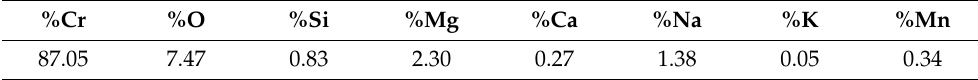
Table 4. SEM analyses of chromium rich particle marked Spectrum 2 in Figure 5 (mass%).